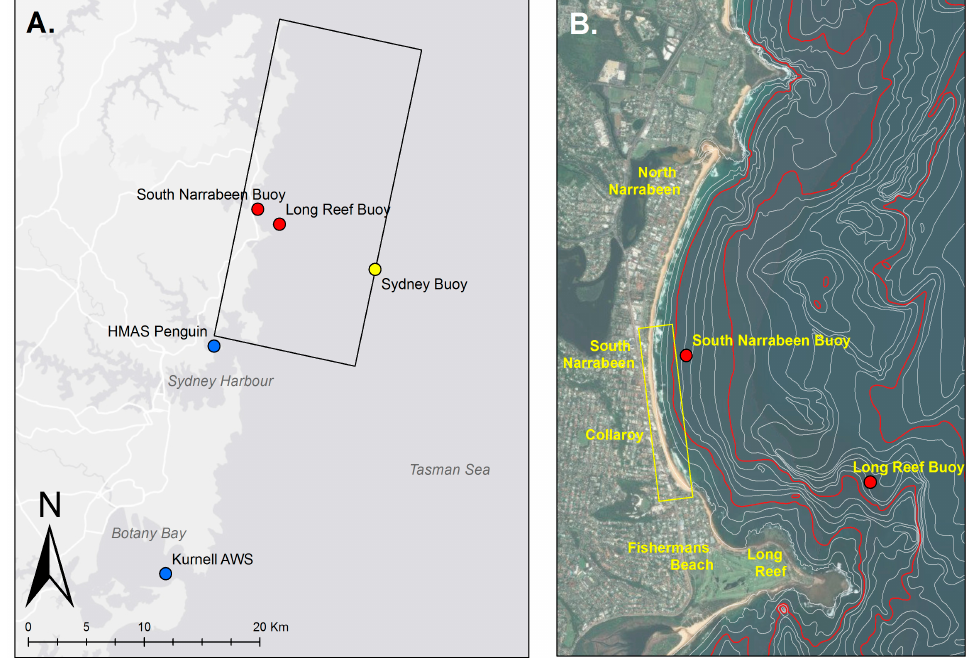
Figure 3. ( A ) Regional map showing approximate extents of numerical model domain (black box); locations of nearshore wave buoys (red); location of Sydney wave buoy (yellow); and locations of tide and wind stations used in this study (blue); and ( B ) local map of Narrabeen–Collaroy beach with bathymetry (5, 15 and 30 m isobaths in red); locations of nearshore wave buoys shown in ( A ); and approximate area of erosion damage at Collaroy during the June 2016 storm (yellow box).